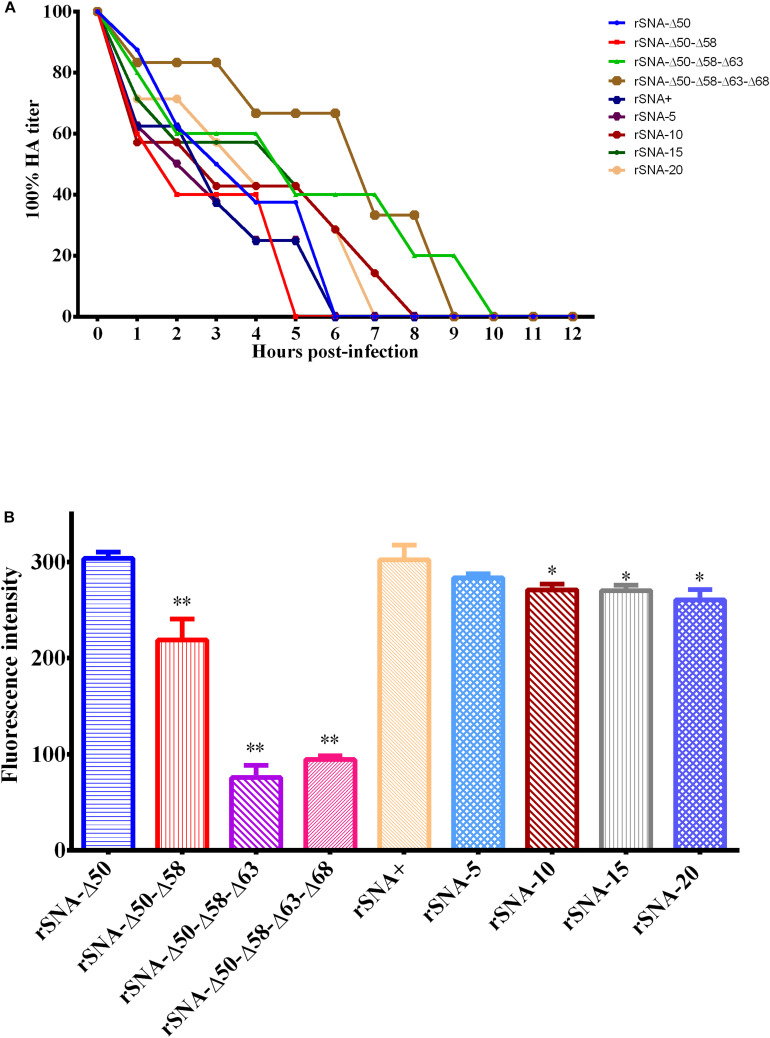
Curves of the recombinant viruses released from the red blood cell surface (A) and neuraminidase activity assays of them (B). *P < 0.05, **P < 0.01, compared to the value of the rSNA+.